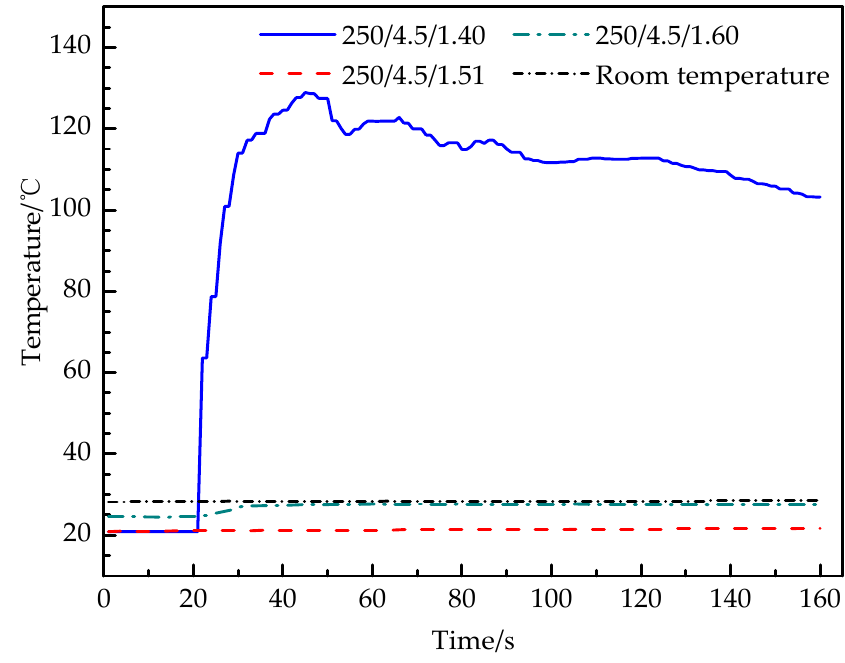
Figure 6. Temperature–time curve of experiments 5, 6 and 7.